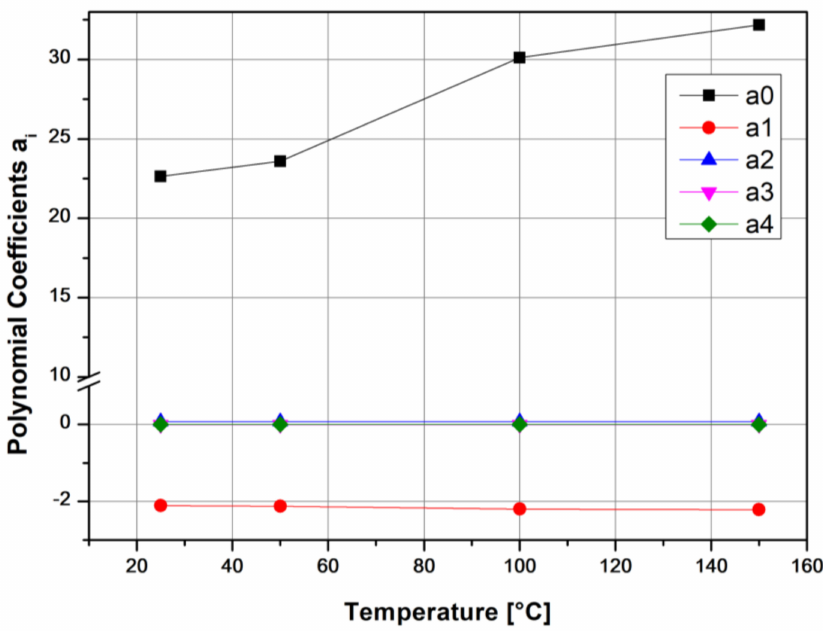
Figure 6. Kevlar/aluminum–glass composite hybrid creep, TTS, polynomial constants as a function of reference temperature